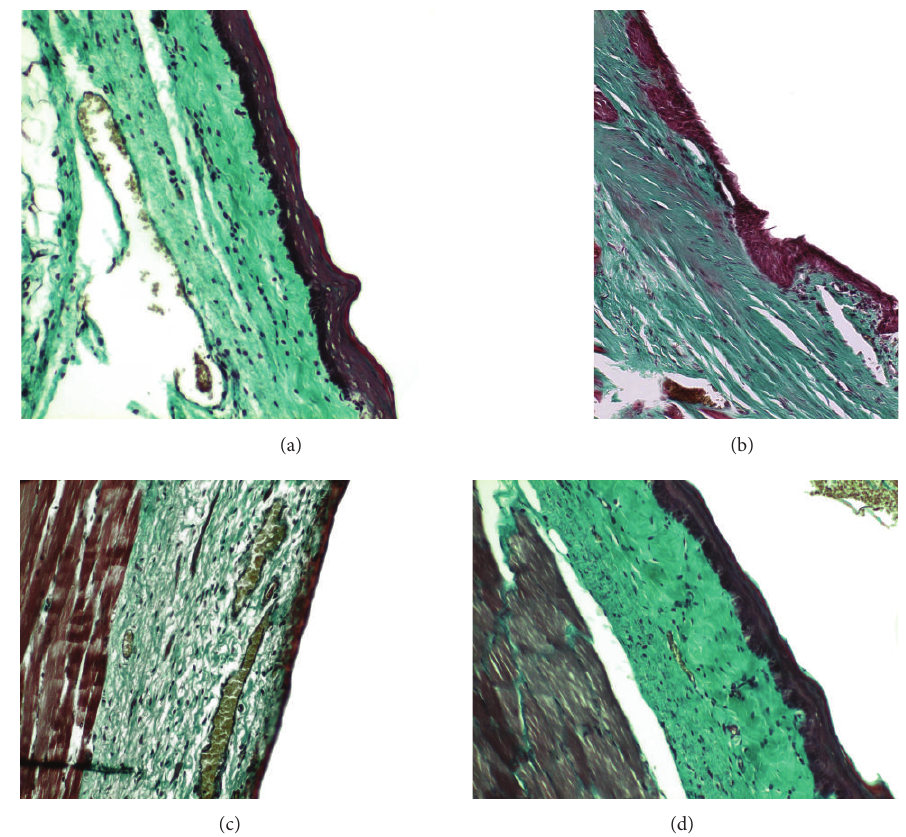
Figure 10: (a) Normal vocal fold. (b) Scarred vocal fold. (c) Injection of ADSC. (d) Injection of